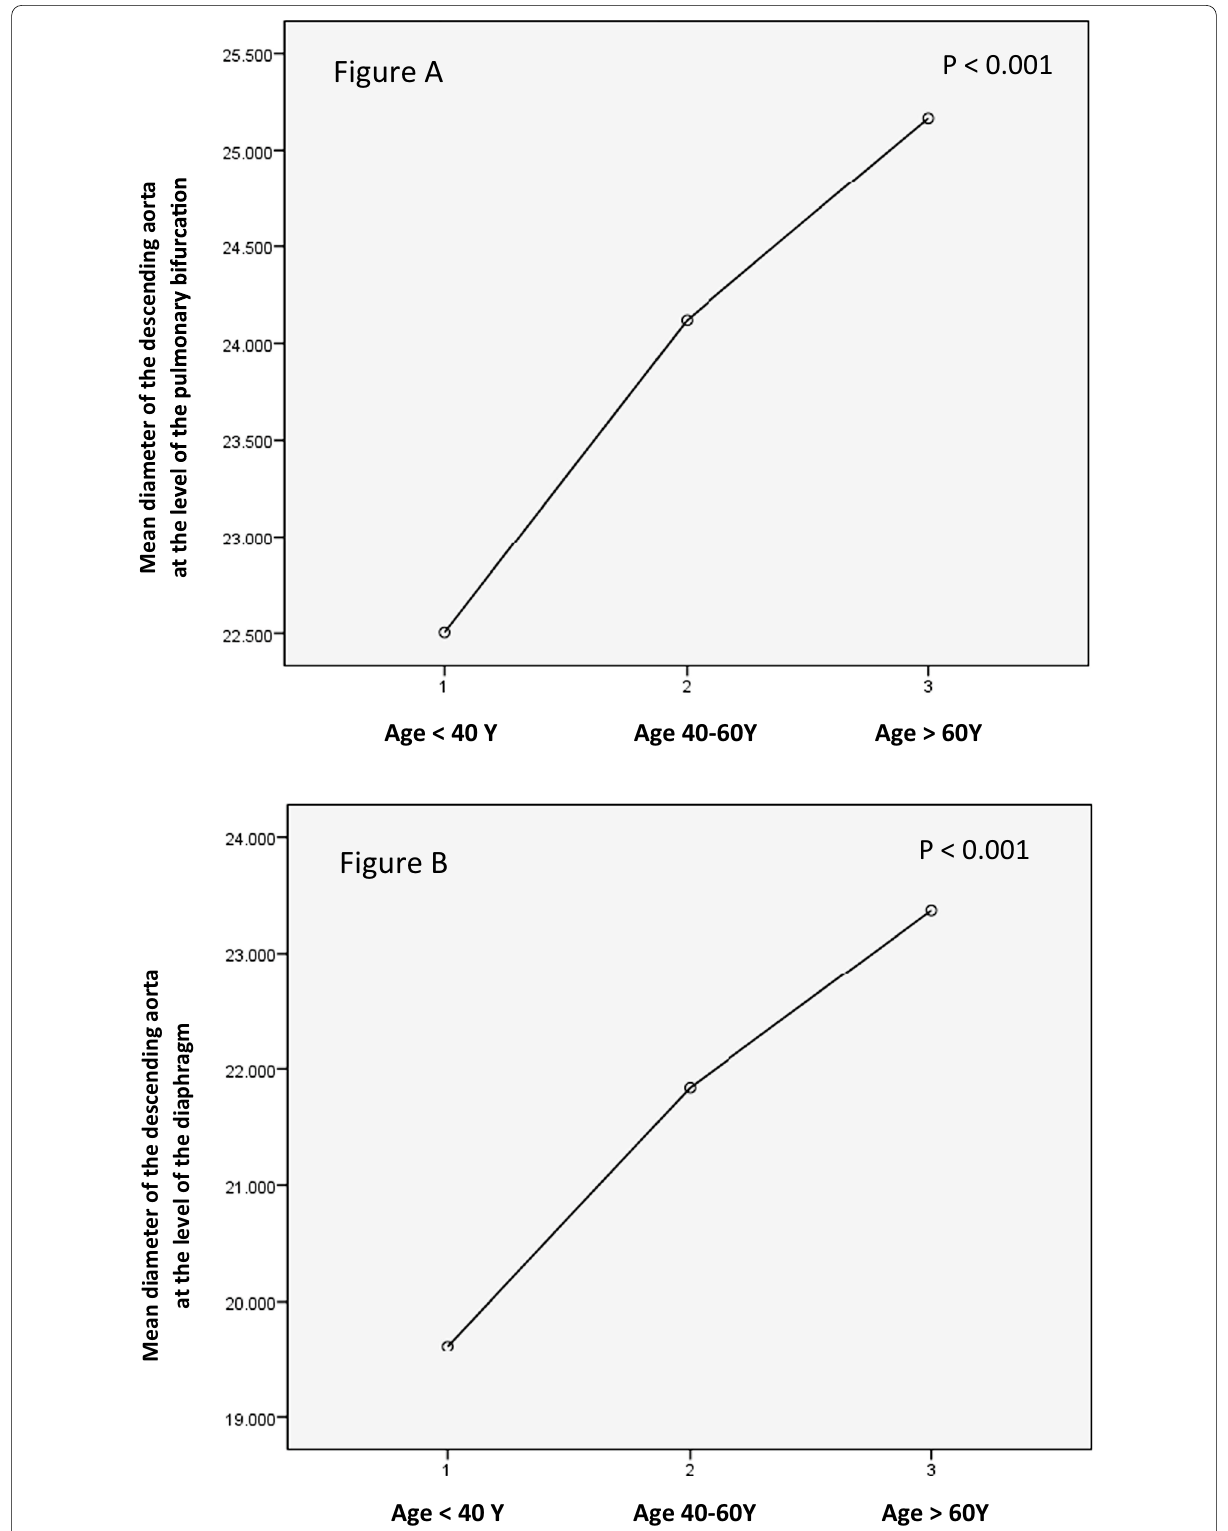
Fig. 6 a Mean diameters of the descending aorta at the pulmonary bifurcation level in the age groups (< 40 Y, 40–60 Y and > 60 Y) and b mean diameters of the descending aorta at the diaphragm in the age groups (< 40 Y, 40–60 Y and > 60